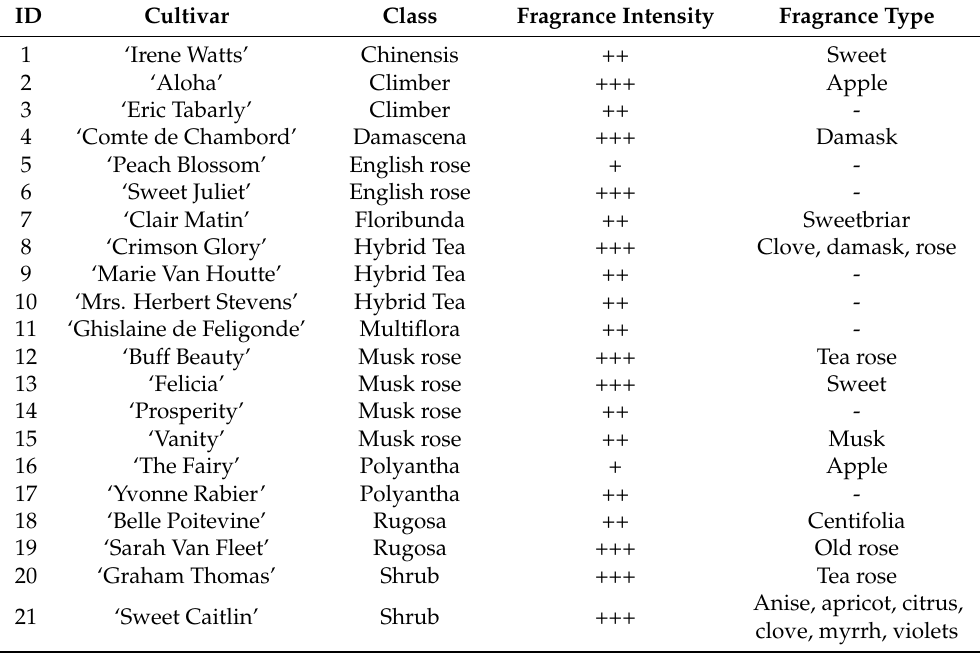
Table 1. Identification number, cultivar, class [31], fragrance intensity (+, mild; ++ moderate; +++ strong) and type [32] of the tested garden roses ( Rosa